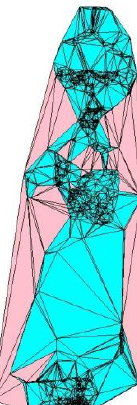
(a) Image taken when turntable was rotated 5°